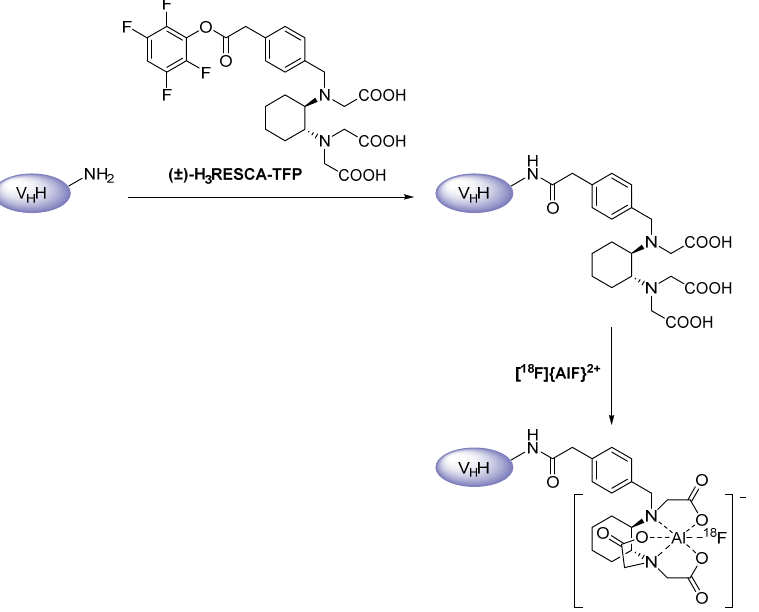
Figure 10. Conjugation of (±)-H 3 RESCA-TFP to primary amines of the nanobody, followed by Al 18 F-labeling [49,50].